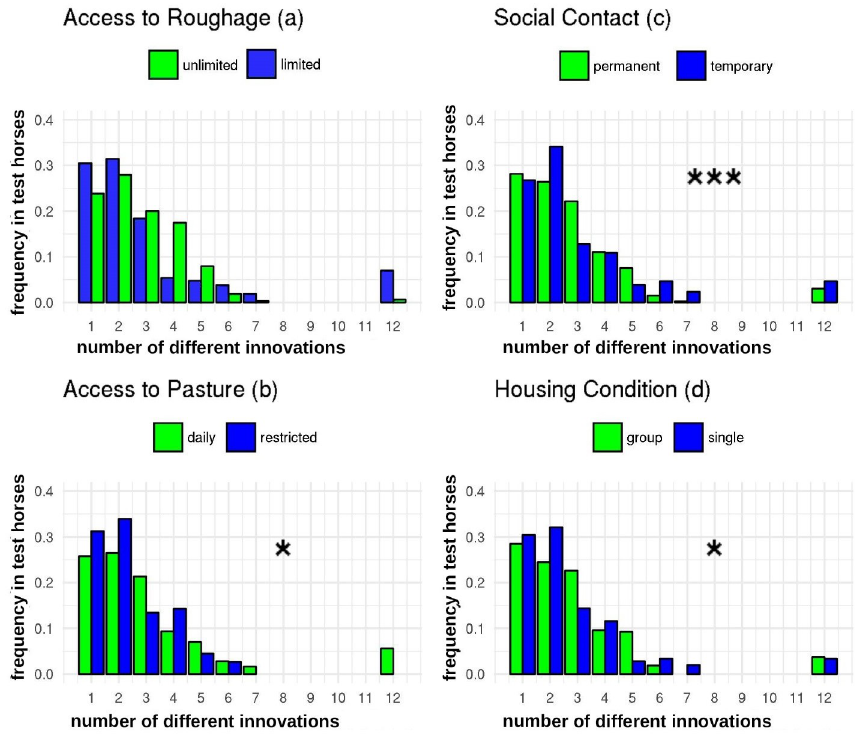
Fig 2. Diversity of innovative behaviour in four management conditions in equids. The x-axis shows the numbers of different types of innovations displayed by the equids and the y-axis the frequency of each number in the population, with 0 = 0% and 1 = 100% of the test animals. The green bars show unrestricted management conditions and the blue bars restricted management conditions for a) access to limited or unlimited roughage, b) access to pasture on a limited number of days per week or daily, c) permanent or temporary contact with other equids, and d) single or group housing. Statistical differences between the green and the blue bars are symbolised with � = p < 0.05 and ��� = p < 0.001 in graph b, c, and